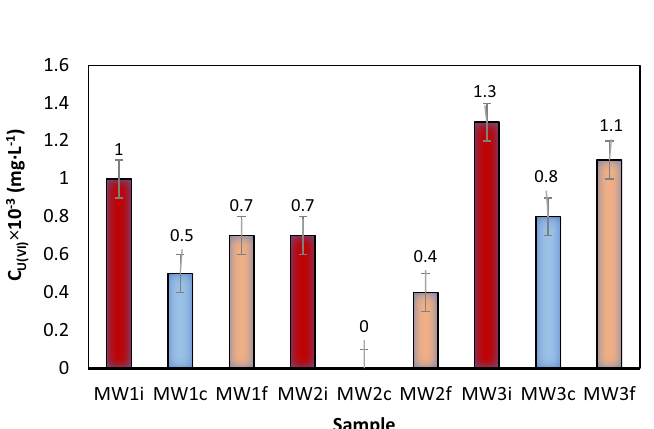
Figure 13. U(VI) residual concentration change in three real water samples after immobilization—sorption / flotation processing, where: MW1i–MW3i is the liquid phase resulting after immobilization on NMS; MW1c–MW3c is a liquid phase with pH adjusted with FeCl 3 0.1 ; MW1f.–MW3f. is the liquid phase resulting after the immobilization on NMS, decantation, collector addition, and